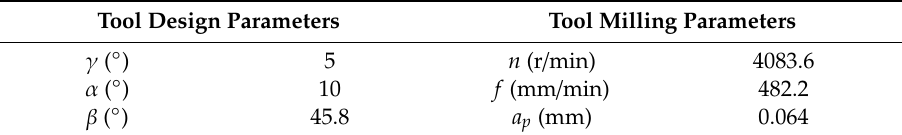
Table 5. GA optimization